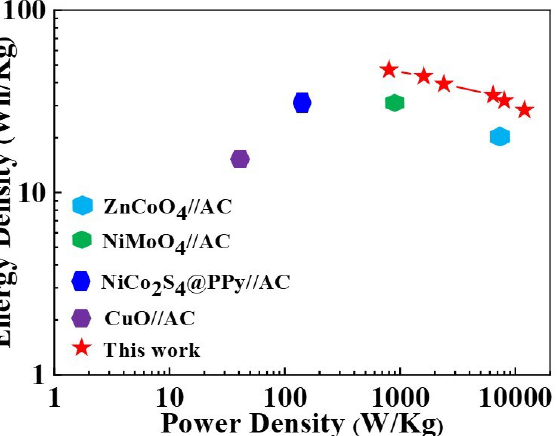
Figure 8. The Ragone plots relating power density to energy density of the asymmetric supercapacitor device [31 – 34].